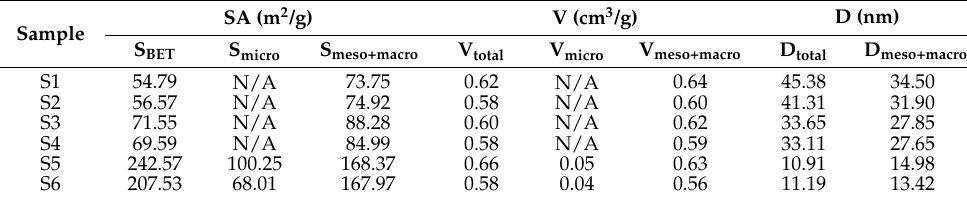
Table 2. Textural properties of AWTCs at six